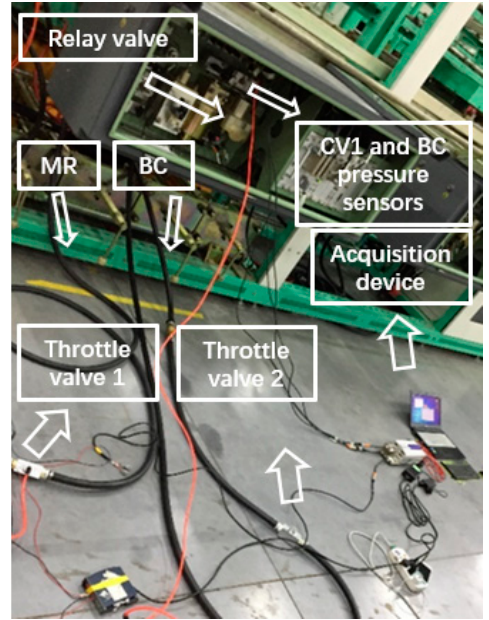
Figure 5. Relay valve leakage simulation test